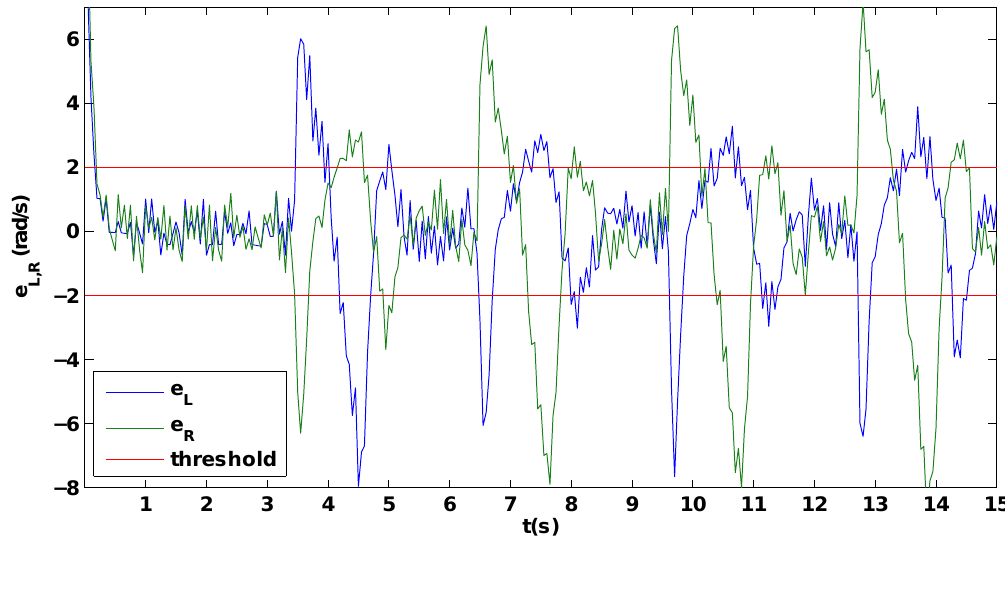
Figure 8. Reference error evolution in the PID control of the Left and Right wheels velocities e and threshold L;R